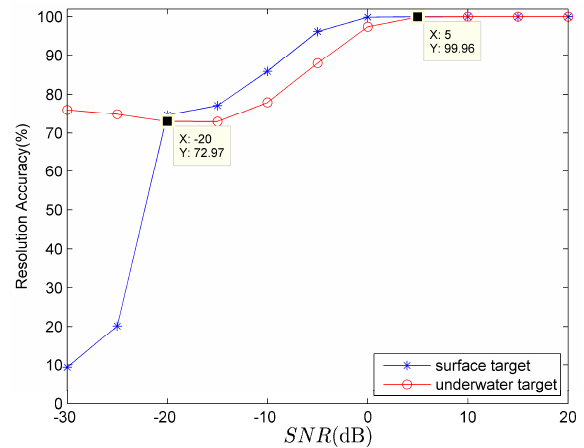
Figure 6. The relationship between target category-resolution accuracy and SNR .